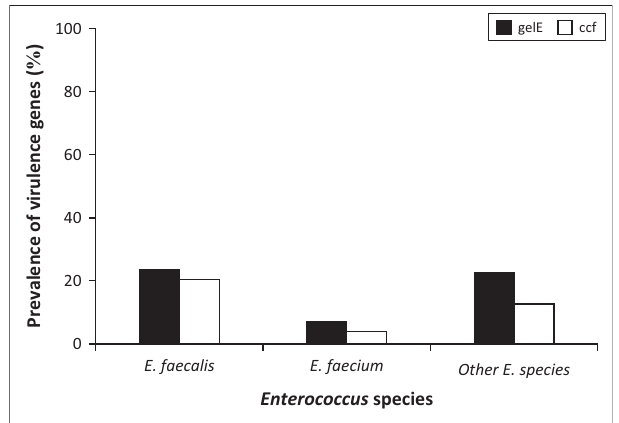
FIGURE 6: Prevalence of each virulence gene detected within each Enterococcal TABLE 3: Chi-square test, likelihood ratio and Fischer’s exact test for target Enterococcus spp. and virulence genes. Source of variation Statistical test